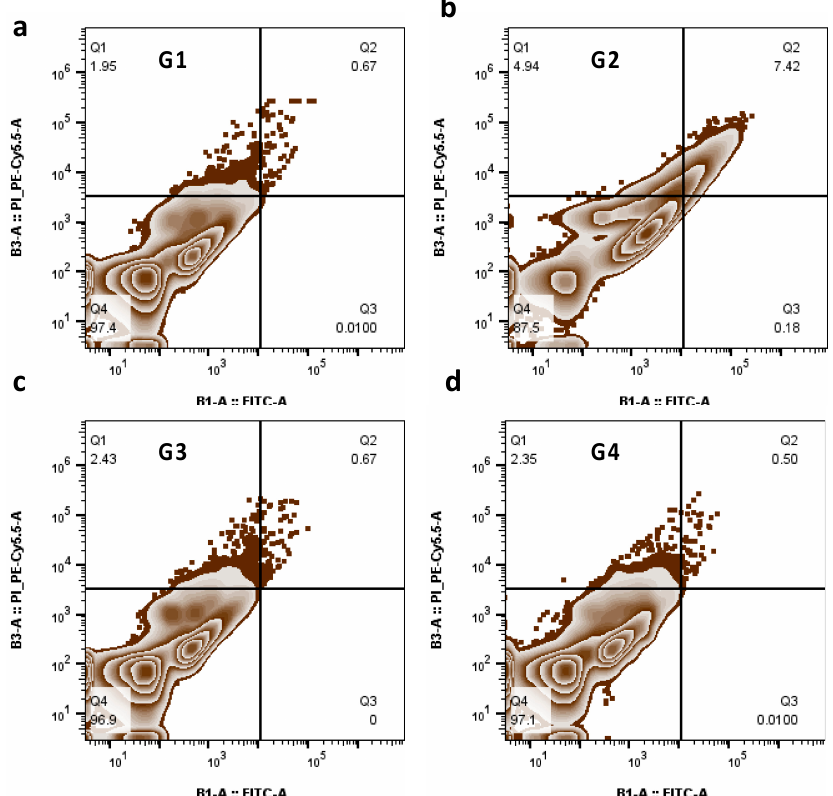
Figure 9. Flow cytometry data of PGD 2 ’s effect on apoptosis: ( a ) control group shows 97.4% viable cells; ( b ) in the LPS-treatment group (5 mg/kg b.w.), total viable cells decreased to 87.5%; ( c ) LPS + PGD 2 group had a reduced apoptosis ratio of 96.9%; ( d ) PGD 2 (100 µ g/kg b.w.)-treated animals displayed no noteworthy comparison in relation to the control animals.